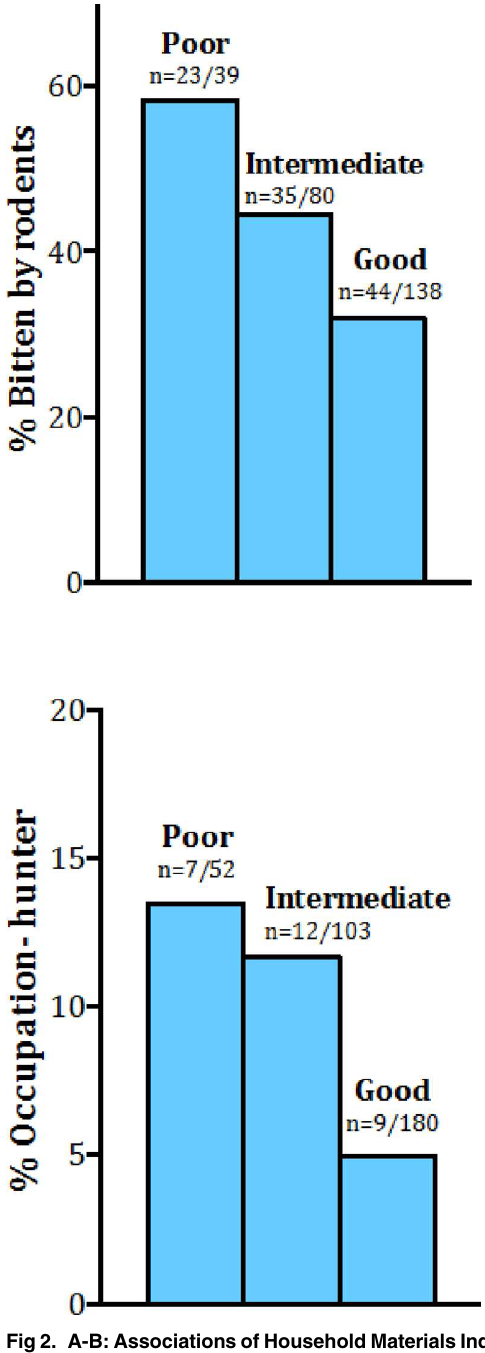
Fig 2. A-B: Associations of Household Materials Index (HMI) and presumptive monkeypox (MPX) risk factors. A. reported themselves or others as having beenbitten by rodents in their household(n = 102), χ 2 p value = 0.0084, B. reportedtheir occupationas a hunter (n = 28) χ 2 p value =